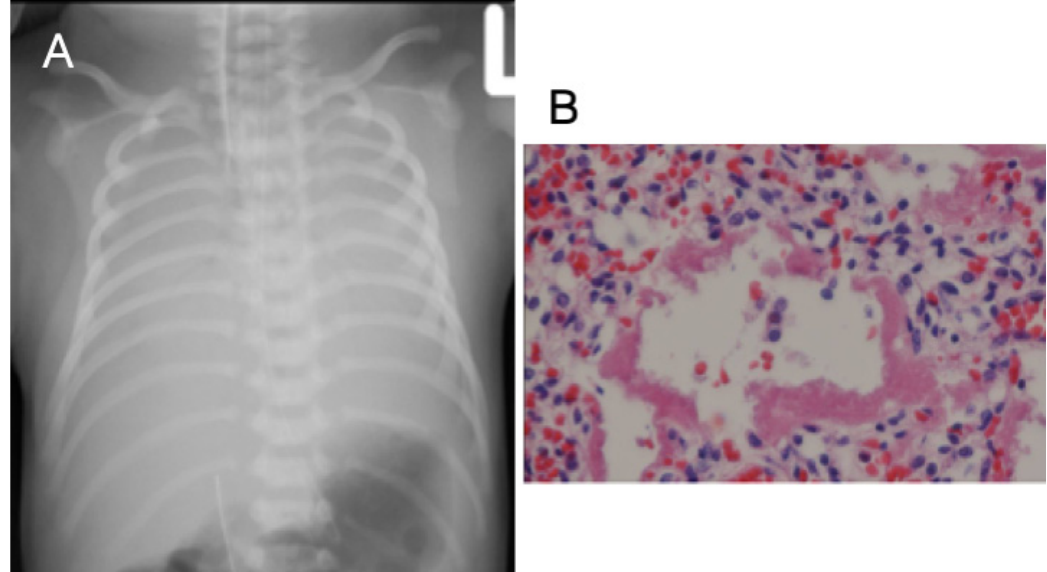
Figure 1. ( A ) Chest radiography of a male neonate presenting with cyanosis and pulmonary hypertension, revealing diffuse ground glass lungs with low volumes; ( B ) lung section showing that the alveolar ducts, alveoli, and terminal and respiratory bronchioles are lined with an eosinophilic hyaline membrane with necrotic alveolar lining cells and fibrin (40×).